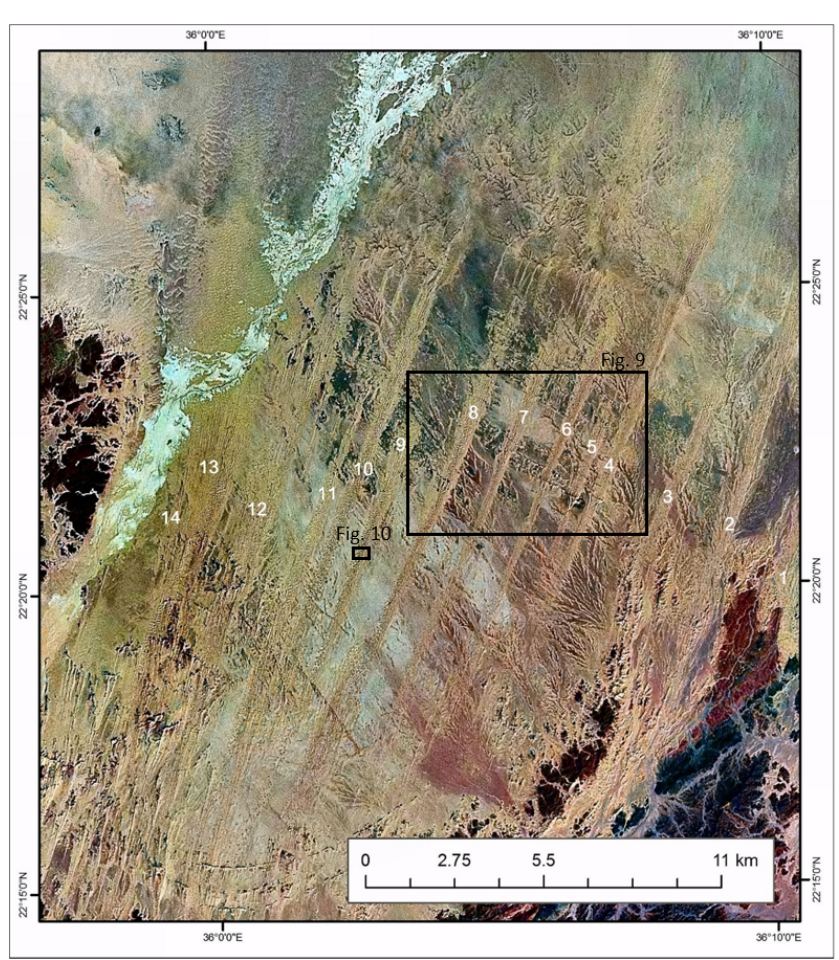
Figure 8. The El-Hebal Dune Field. White numbers mark the identified longitudinal units (comp. Table 8). Source: Landsat TM image. Table 8. Morphological Characteristics of linear dunes of El-Hebal Dune Field.